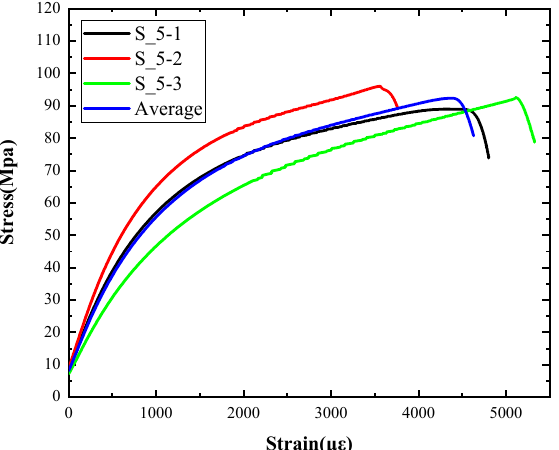
Figure 5. Stress–strain curve of 5 m/s.